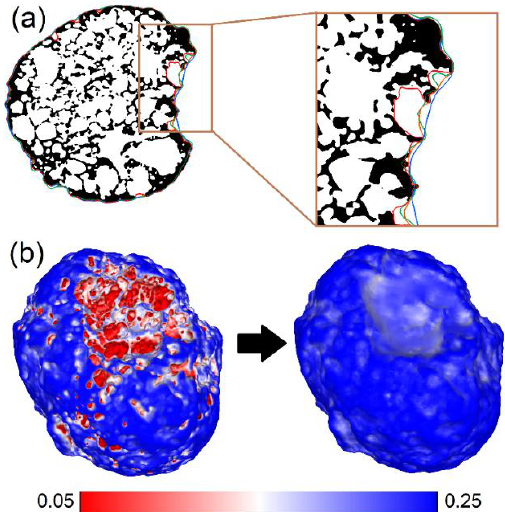
Figure 2. Influence of the Ambient Occlusion threshold on the determined CT model’s envelope: ( a ) Cross-section of grain C1’s full CT model, ( b ) External surface of grain C1 obtained after the simpli- fication with the threshold 𝑡 = 0.05 ( left ) and 𝑡 = 0.175 ( right ).